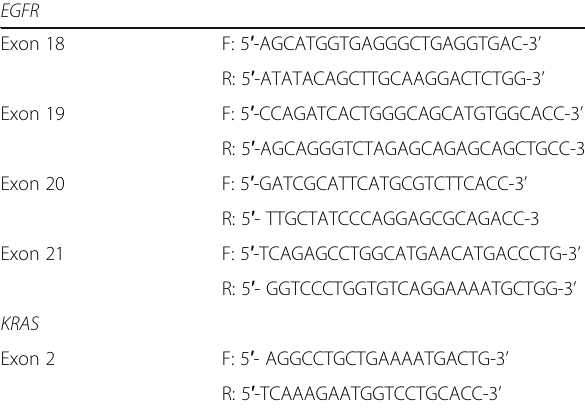
Table 2 The primers of EGFR and KRAS on hot spots